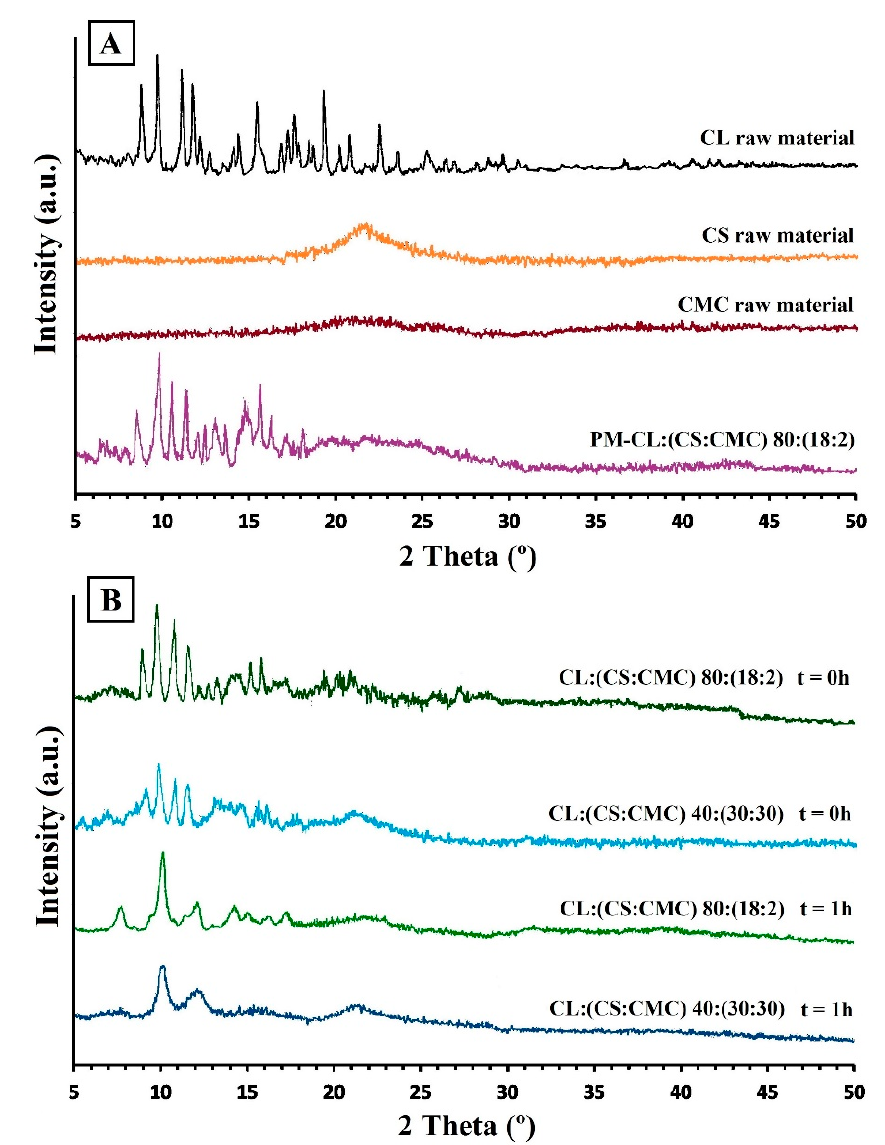
Figure 4. ( A ) PXRD of clarithromycin (CL), chitosan (CS), carboxymethyl cellulose (CMC), physical mixture of PM-CL:(CS:CMC) 80:(18:2). ( B ) PEC tablets CL:(CS:CMC) 80:(18:2) and CL:(CS:CMC) 40:(30:30) at 0 h and after 1 h in dissolution medium (pH 4.2).